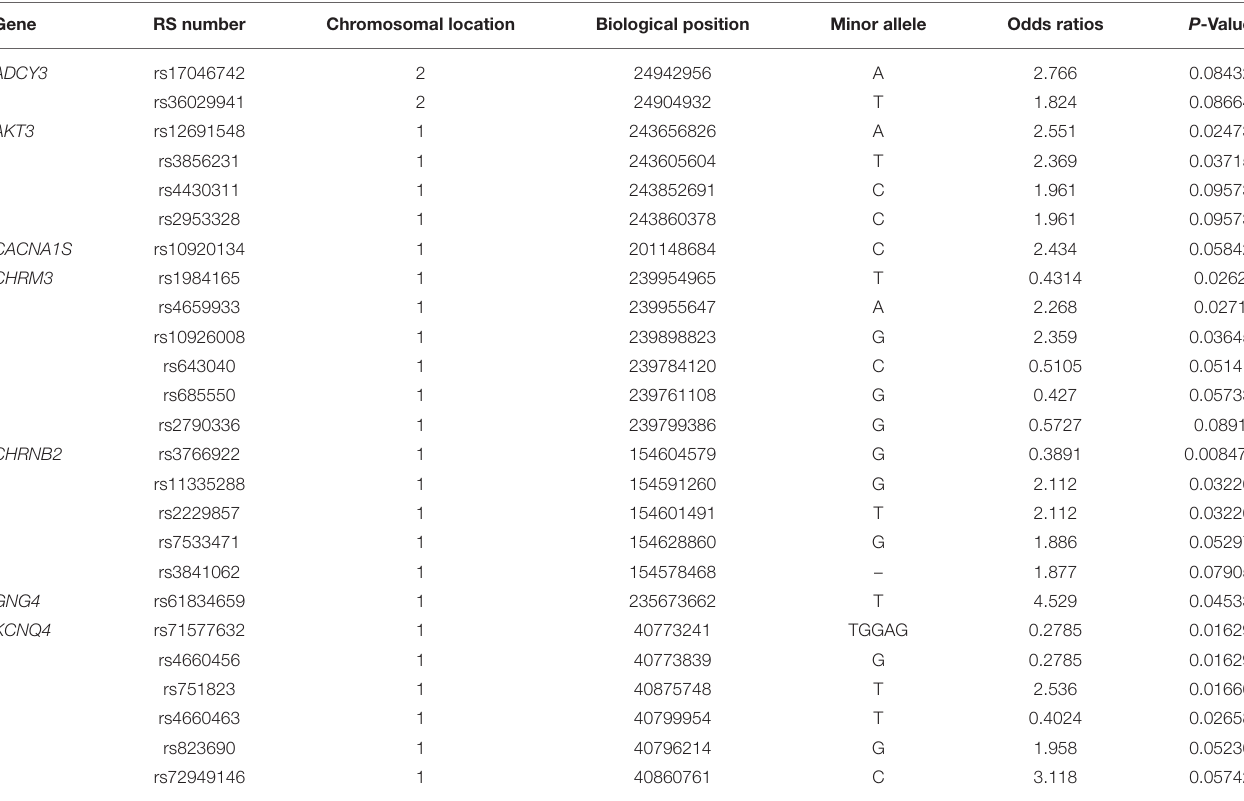
TABLE 2 | Significantly different SNPs between participants with persistent and acute congestion. Gene RS number Chromosomal location Biological position Minor allele Odds ratios P